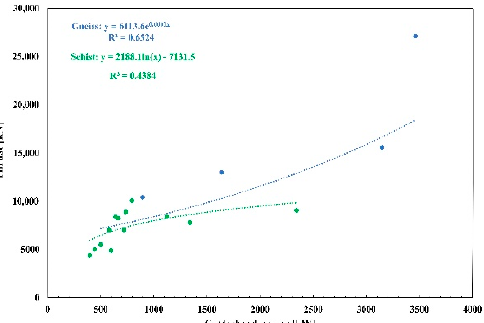
Figure 12. Correlation between the power and the thrust due to the excavation in gneisses and schists by open TBMs.